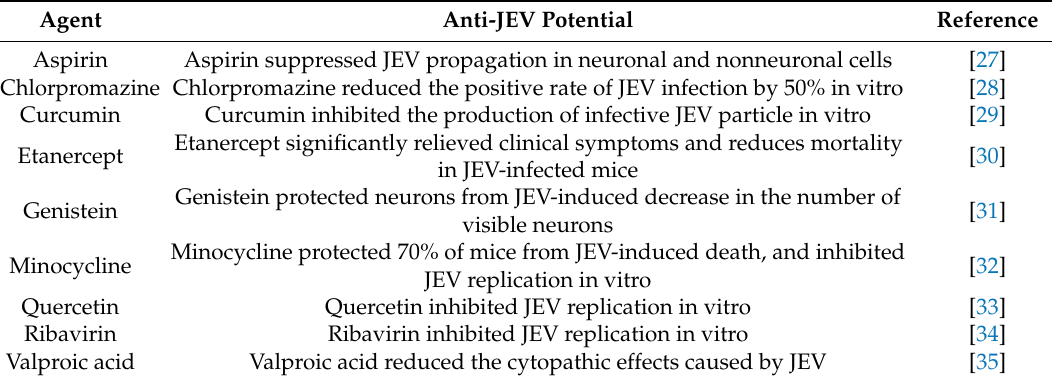
Figure 3. The chemical structure of bortezomib. Table 1. Agents reported to have an effect on the treatment of Japanese encephalitis virus (JEV) infection. Among these agents, the effect of minocycline and ribavirin on the treatment for JEV has been tested by randomized clinical trials [37,38]. Etanercept and minocycline inhibited JEV replication both in vitro and in vivo.